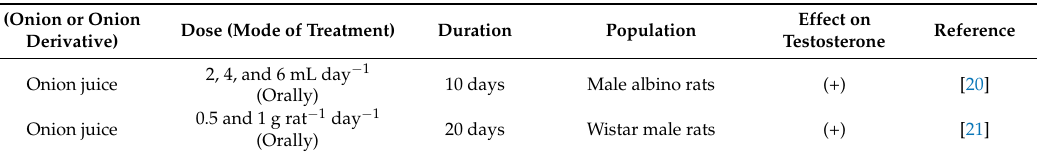
Table 1. A summary of the research studies conducted on onions or onion extracts and their reported effects on